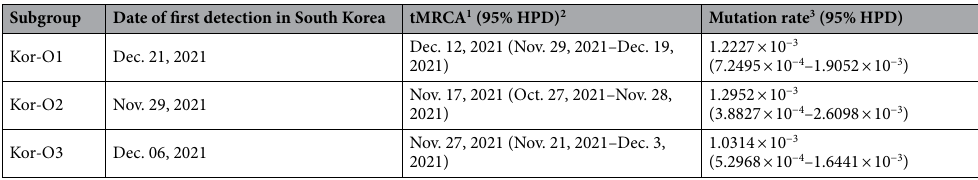
Table 1. First detection date, mutation rates, and time to most recent common ancestor of each Korean Omicron subgroup. 1 Time to most recent common ancestor. 2 95% HPD, 95% height posterior density. 3 Substitutions/site/year.